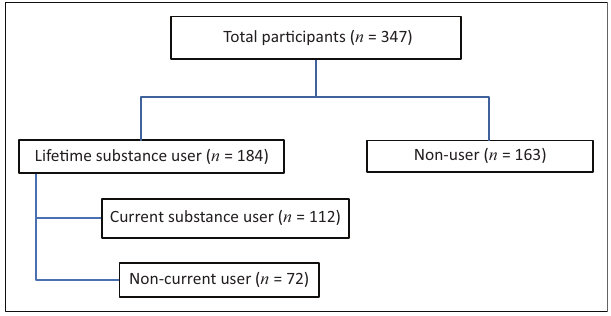
FIGURE 2: The distribution of participants in the current